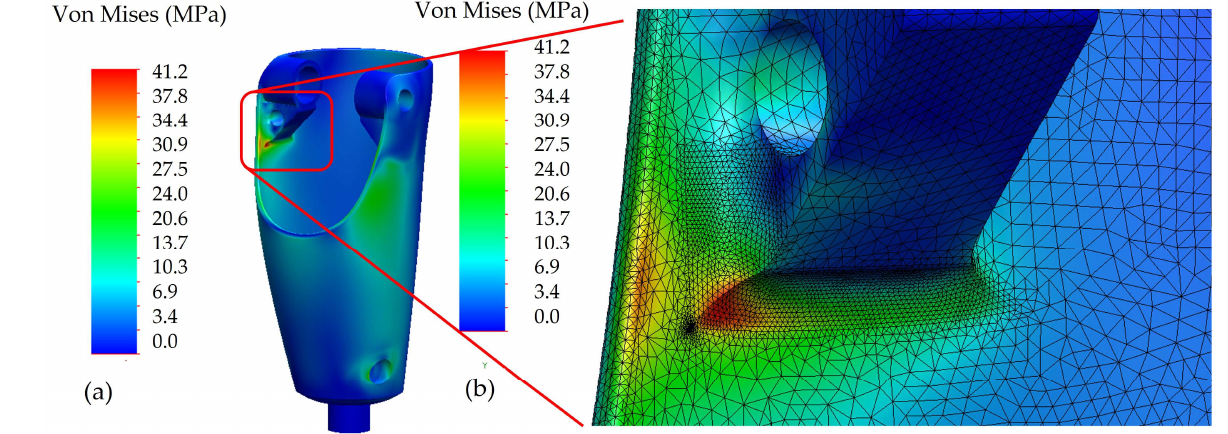
Figure 11. FEM analysis for the housing: ( a ) stress; ( b ) close-up of the area with the most stress, including mesh details.